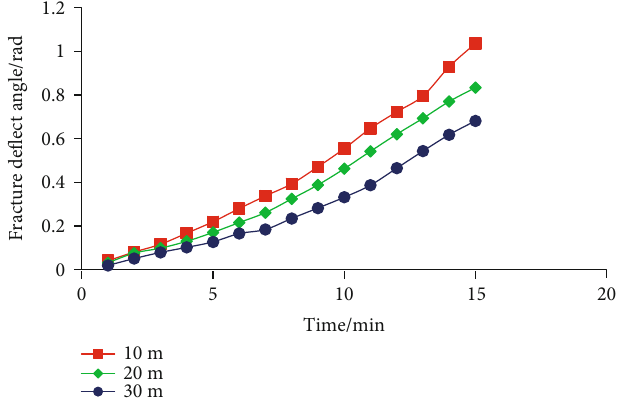
Figure 11: Evolution of de fl ection angle as a function of time under di ff erent spacings.